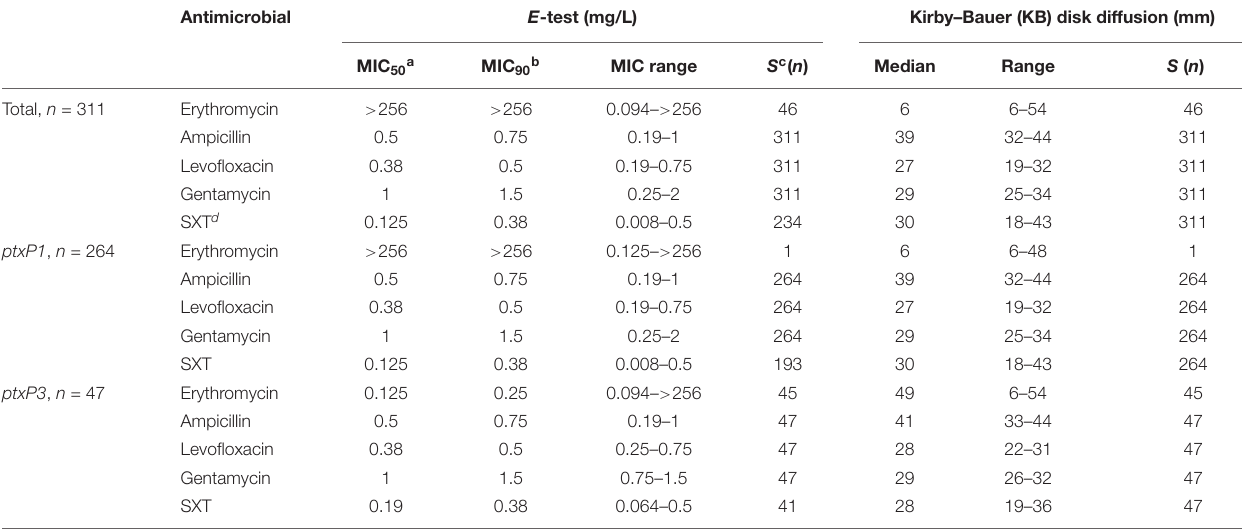
FIGURE 1 | Geographic distribution of the 311 culture-confirmed pertussis cases at the time of onset, mainland China, 2017–2019. Different colors represent different geographic regions. The size of green circles indicates the number of patients in the province. TABLE 1 | Antimicrobial susceptibility of the presented 311 Bordetella pertussis isolates in China during 2017–2019. Antimicrobial E -test